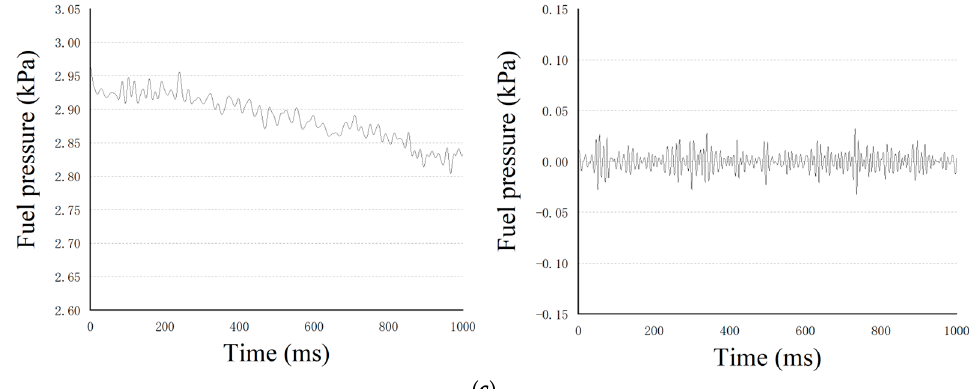
Figure 9. ( a ) The high − frequency signal ( left ) and the low − frequency signal ( right ) after the first − level decomposition; ( b ) The high − frequency signal ( left ) and the low − frequency signal ( right ) after the second − level decomposition; ( c ) The high − frequency signal ( left ) and the low − frequency signal ( right ) after the third − level decomposition.